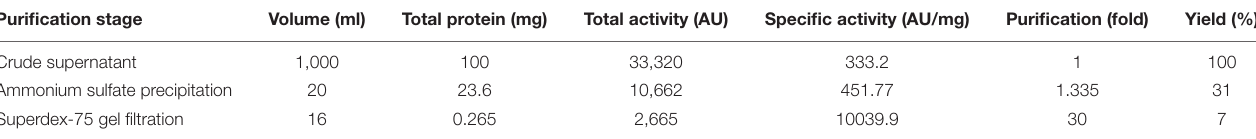
TABLE 3A | BAMP purification table.